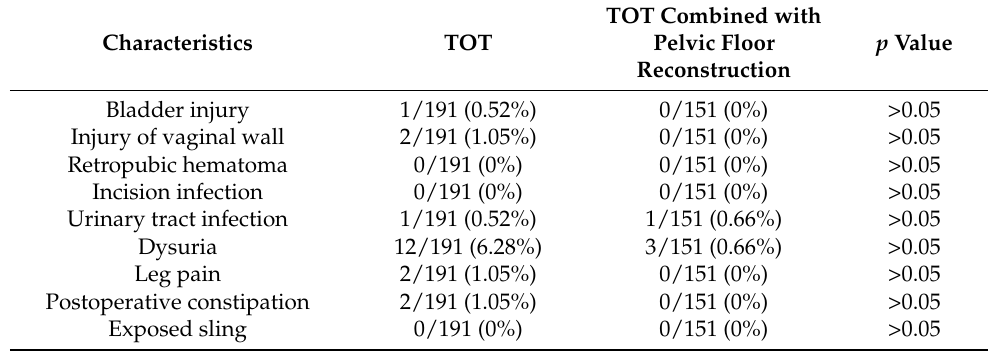
Table 2. Surgical